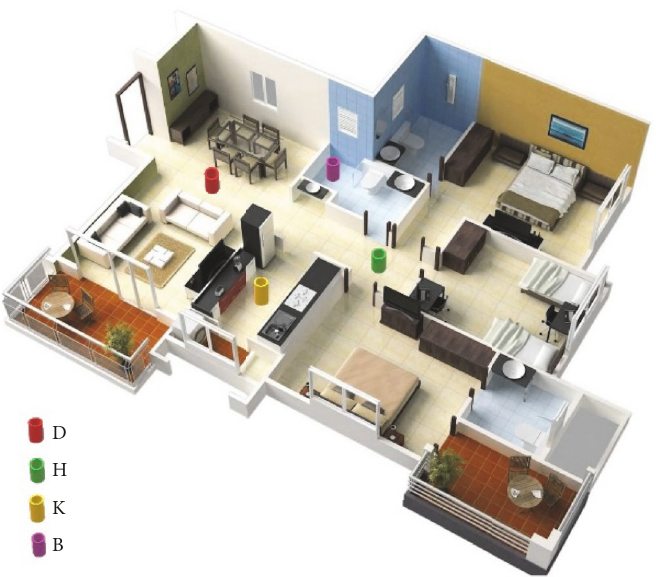
Figure 1: A representative example of living environment of an older adult with definition of various key markers. The key nodal sensing points are dining room (D); hallway (H); kitchen (K), and bathroom (B). Figure 1 is reproduced from Payandeh, 2018 [11] (under the Creative Commons Attribution License/public domain).